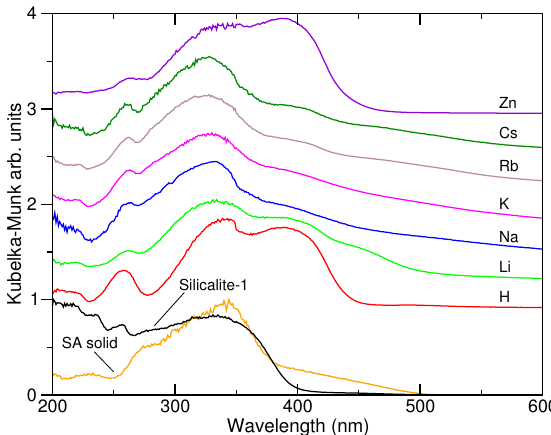
Figure 2. Diffuse reflectance UV-vis spectra of SA@M-ZSM-5